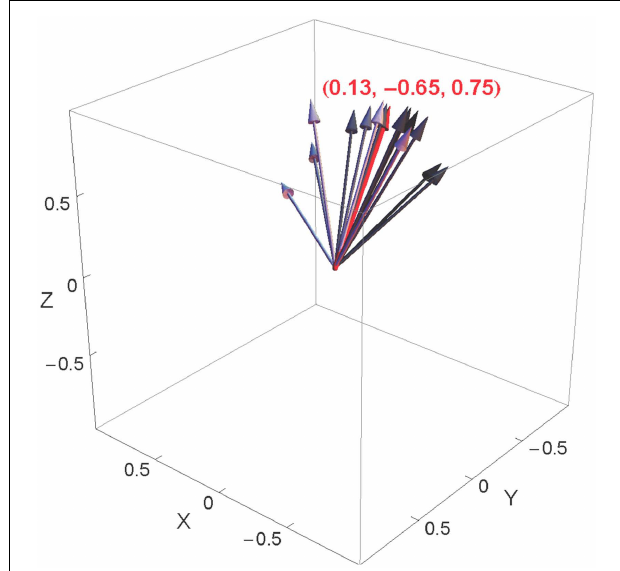
FIGURE 9 | Individual head rotation axes represented in the space of rotations, shown in gray, as well as their mean, shown in red. The individual axes are shown in shades of gray that correspond to the value of the spontaneous rotation coefficient (the darker the arrow, the higher the corresponding coefficient).The three Euclidean coordinates represent the mean axis.